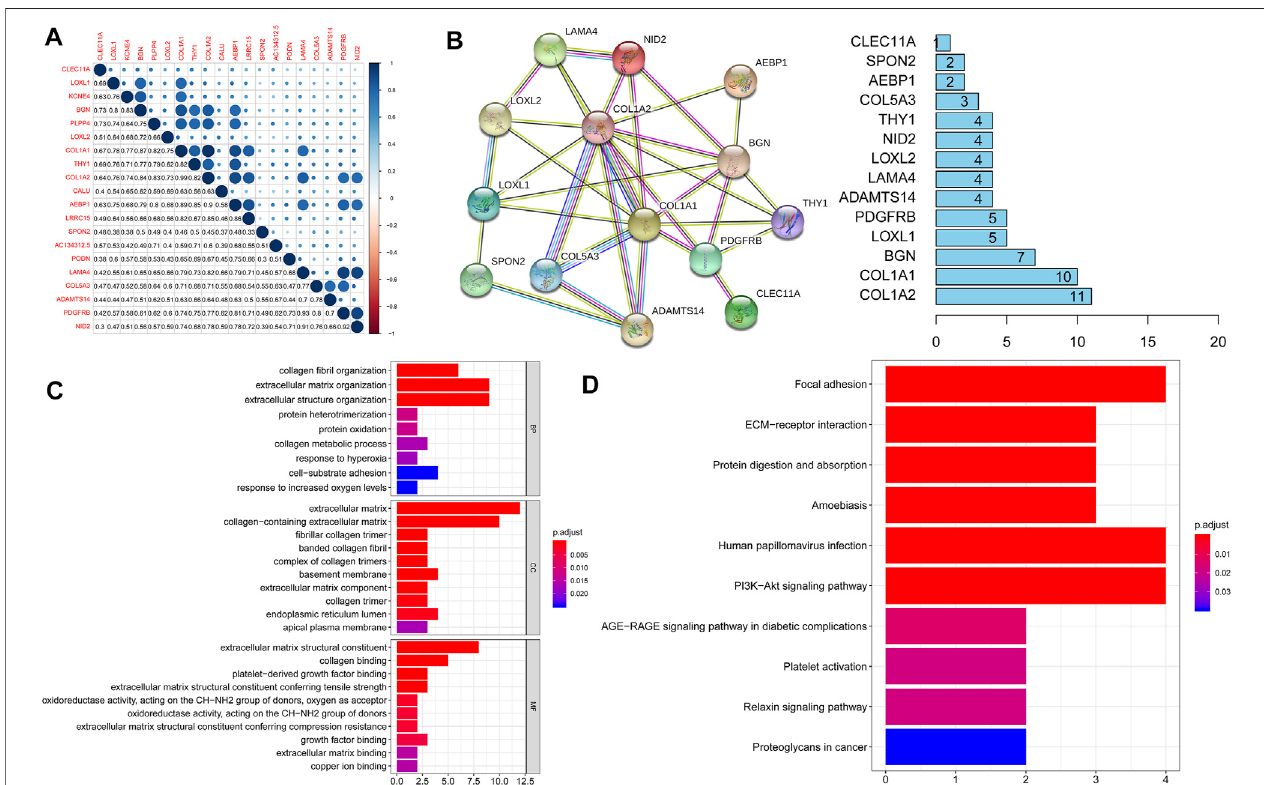
FIGURE 3 | (A) . Function analysis of the DEGs. The co-expression of these 20 key genes showed the correlation with the lowest connection was between NID2 and CLEC11A(0.3),whilethatwiththehighestconnectionwasbetweenCOL1A1andCOL1A2(0.99); (B) .STRINGdatabase wasused toconstructtheprotein-protein interaction network and the number of adjacent nodes of each gene showed by histogram; (C) . GO analysis results of 20 key genes in the brown module; (D) . KEGG analysis results of 20 key genes in the brown module.